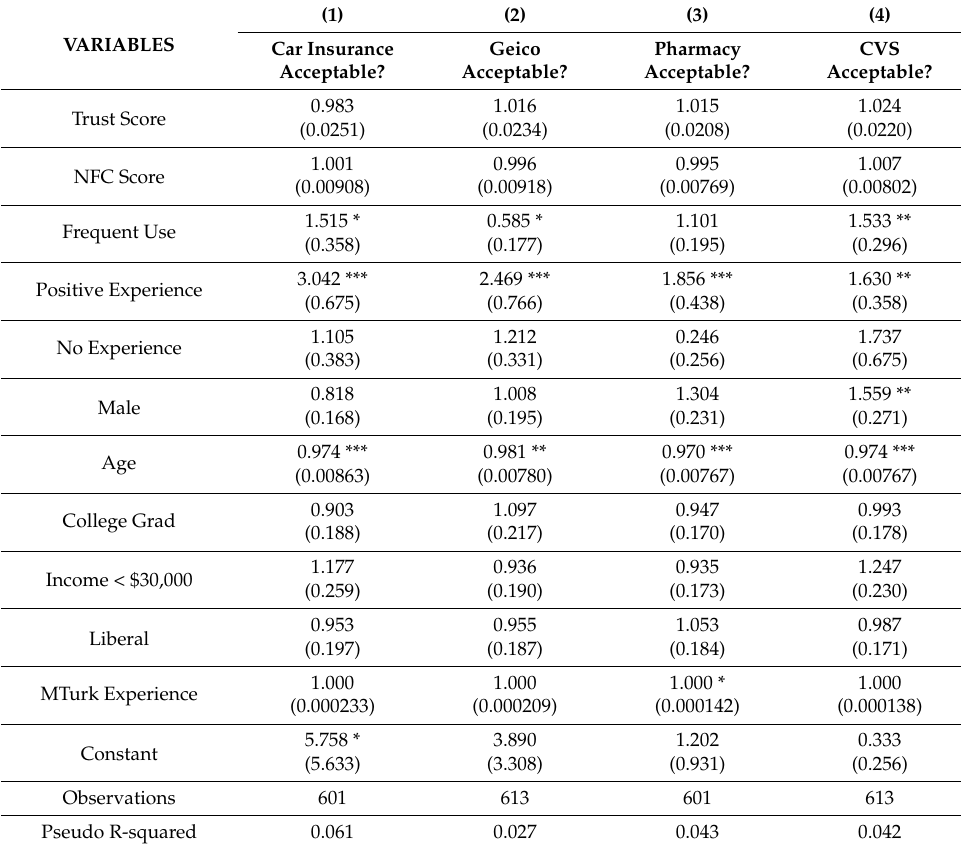
Table 7. Logistic regressions for scenarios involving non-online interactions (coefficients presented as odds